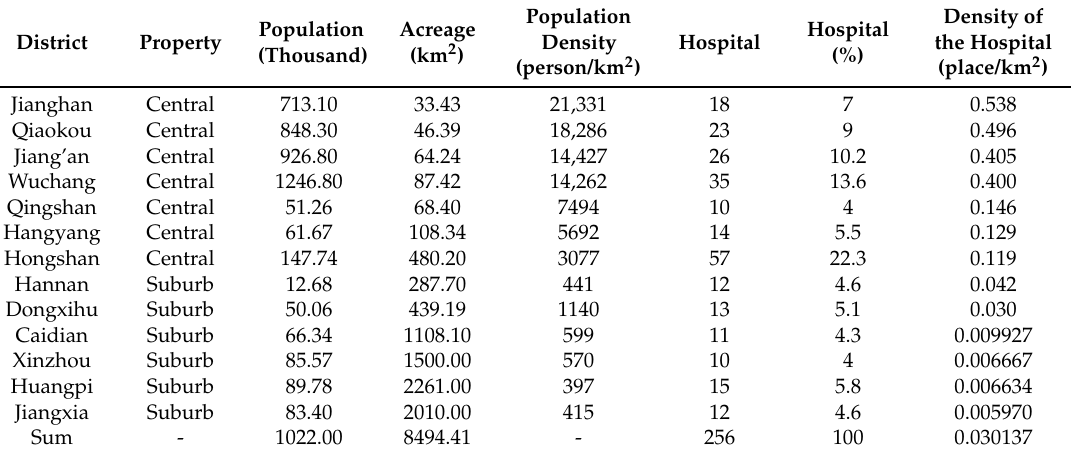
Table 1. Wuhan hospital